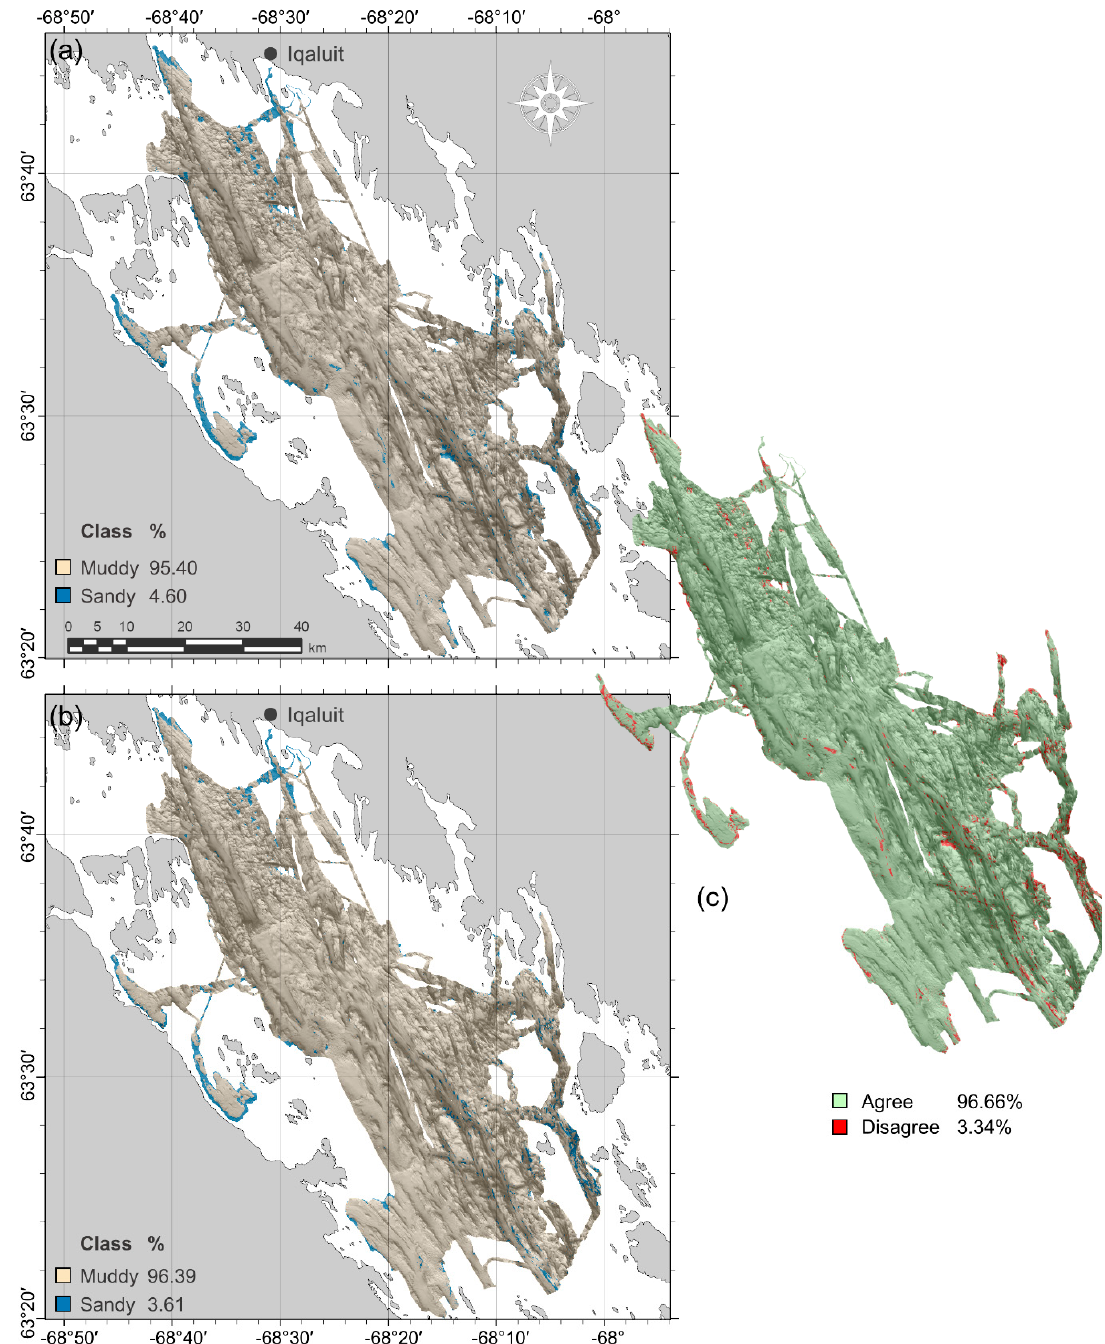
Figure 10. Predicted “muddy/sandy” grain size classes for ( a ) categorical and ( b ) quantitative Random Forest models, with ( c ) agreement between predictions.